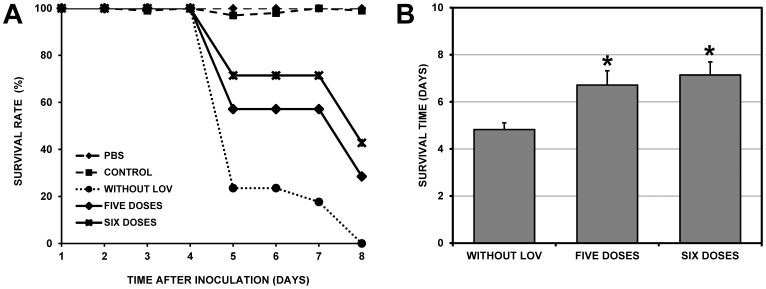
Effect of prolonged LOV treatment on the survival of infected mice.Groups of six mice were subjected to prolonged treatment with LOV (200 mg/kg/day) orally after viral inoculation (post-treatment). The first group received a daily dose for five days (24, 48, 72, 96 and 120 hrs) and the second group received a daily dose for six days (24, 48, 72, 96, 122 and 144 hrs). Inoculations were administered intraperitoneally with a viral dose of 1×106 PFU/ml. Three types of controls groups were used. The “PBS” group consisted of mice that were not treated with LOV and were not infected, the “CONTROL” group consisted of mice that were treated with LOV but were not infected and the “CONTROL WITHOUT LOV” group consisted of mice that were not treated with LOV but were inoculated with DENV-2. The survival rates were compared between the control without LOV group and treated groups (five and six doses groups). A. Kaplan-Meier curve showing the survival rates of the untreated group and the two treated groups. B. Comparison of the survival rates of untreated and treated groups. Asterisks indicate statistically significant differences between treated LOV groups and the control without LOV group. Both treatment schemes, using multiple doses of LOV, significantly increased the survival rates.